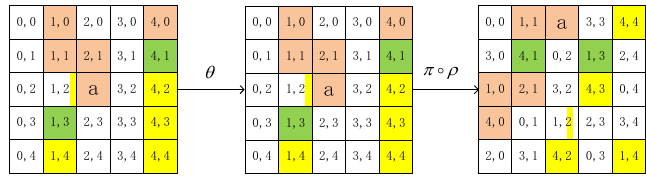
Figure 14: Attack on 7-round Ketje Sr